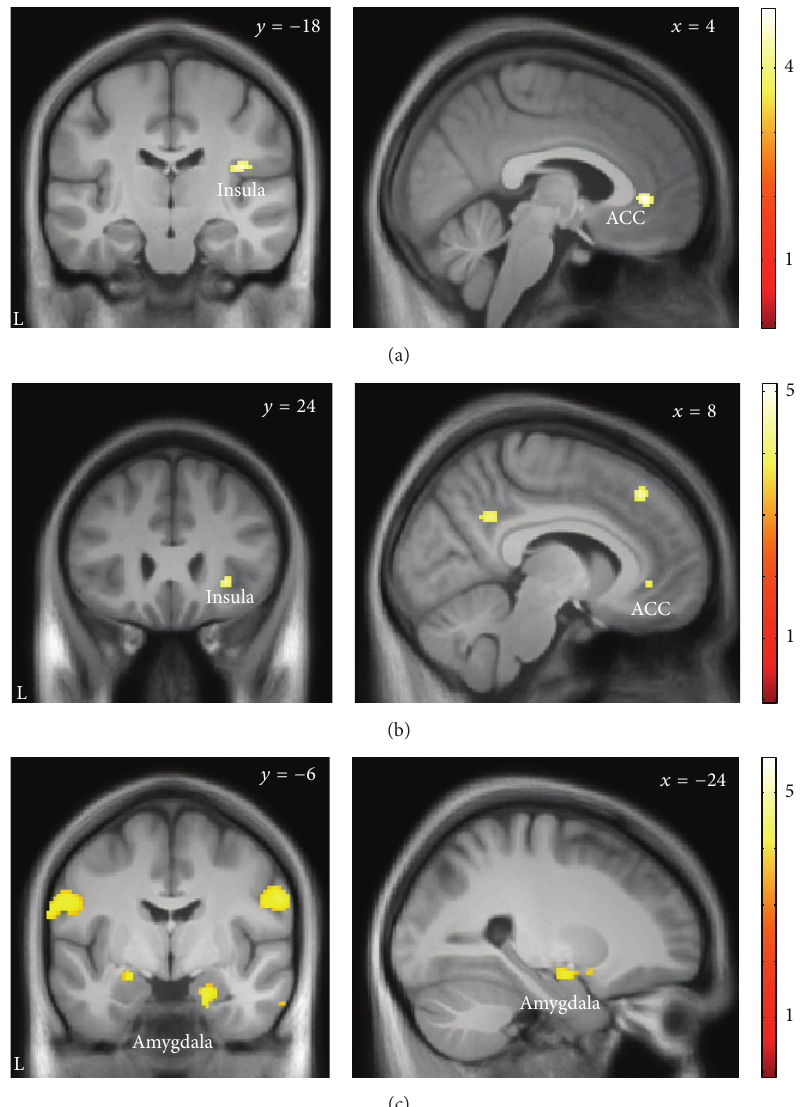
Figure 4: Psychophysiological interactions during the anticipation period. (a) During the anticipation of severe as compared to mild dyspnea the left anterior insular cortex shows significantly increased coactivation with ACC ( 𝑥 = 4 , 𝑦 = 38 , 𝑧 = 0 ; ROI-corrected 𝑝 = 0.003 ) and right insular cortex ( 𝑥 = 36 , 𝑦 = −18 , 𝑧 = 18 ; ROI-corrected 𝑝 = 0.019 ). (b) The left parietal operculum shows increased coactivation with ACC ( 𝑥 = 8 , 𝑦 = 40 , 𝑧 = −4 ; ROI-corrected 𝑝 = 0.029 ) and right insular cortex ( 𝑥 = 30 , 𝑦 = 26 , 𝑧 = −4 ; ROI-corrected 𝑝 = 0.007 ). (c) The left cerebellar cortex shows increased coactivation with the amygdala, bilaterally ( 𝑥 = −24 , 𝑦 = −8 , 𝑧 = −14 ; ROI-corrected 𝑝 = 0.011 and 𝑥 = 22 , 𝑦 = −4 , 𝑧 = −24 ; ROI-corrected 𝑝 = 0.016 , resp.). The nonsignificant interactions within the rostral cingulate cortex (b) and primary sensorimotor cortex (c) were outside our ROIs and did not reach whole-brain-corrected significance. All interactions are displayed at a threshold of 𝑝 < 0.05 , corrected for the specific ROI, and superimposed on the group-specific T1-weighted mean image generated by the